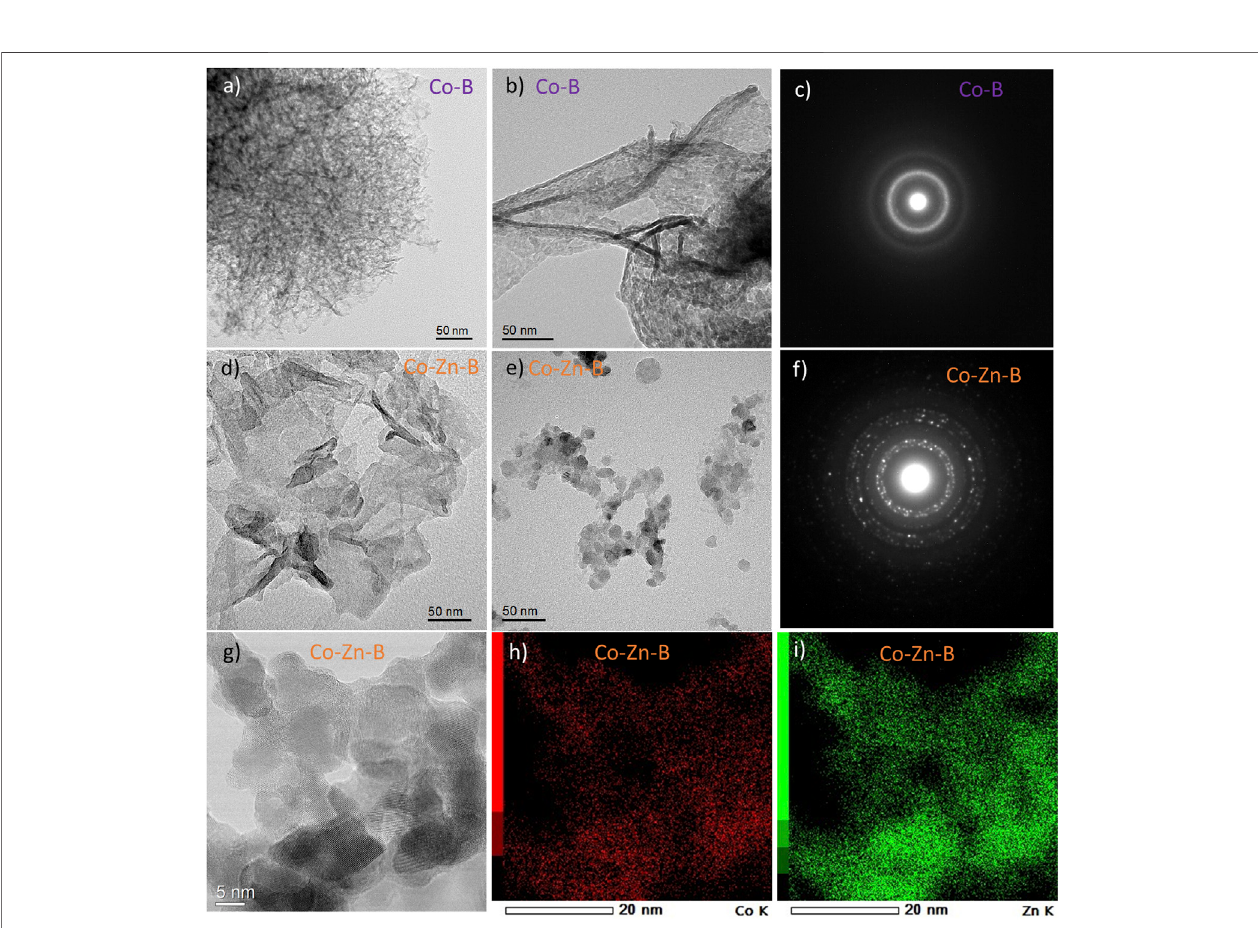
FIGURE 2 | TEM images of Co-B before (A) and after (B) heat treatment and (C) diffraction SAED pattern. TEM images of Co-Zn-B before (D) and after (E) heat treatmentand (F) diffractionSAEDpatternEDSofCo-Zn-Baftertreatment. (G) HighResolution TEMimagesofCo-Zn-B. (H,I) EDXmappingofCoandZndistribution in